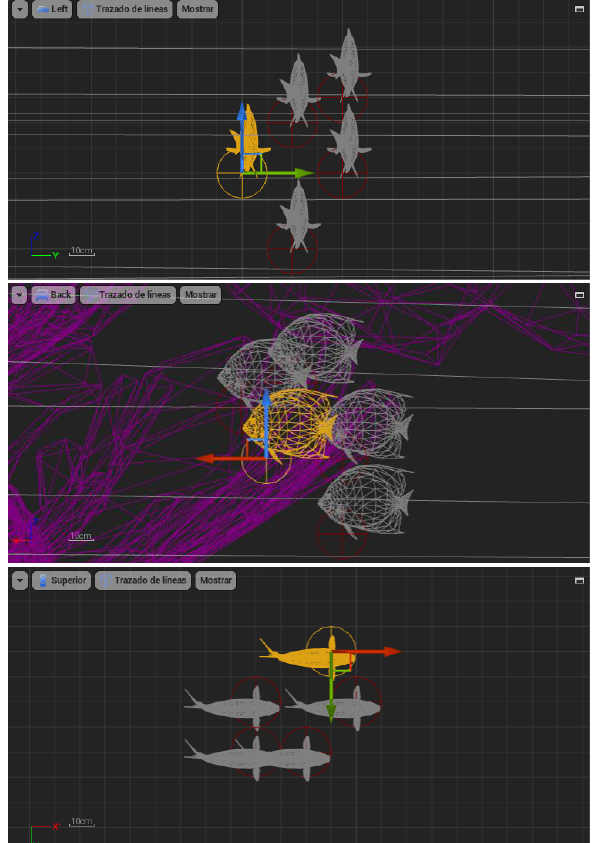
Figure 4. Implementation of collective movement in Unreal Engine under the rules of collision avoidance, polarization, aggregation and self-organized criticality: Circles visualize V for each agent A i from different points of